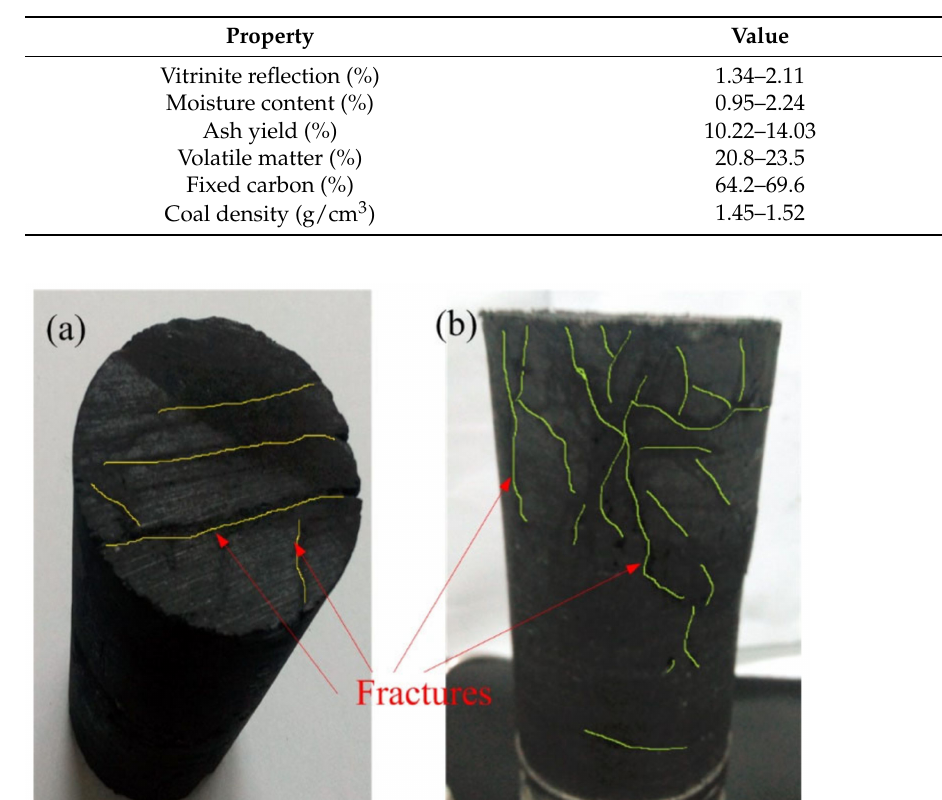
Table 1. Physical properties of the Pingdingshan Coalfield coking coal used for testing.